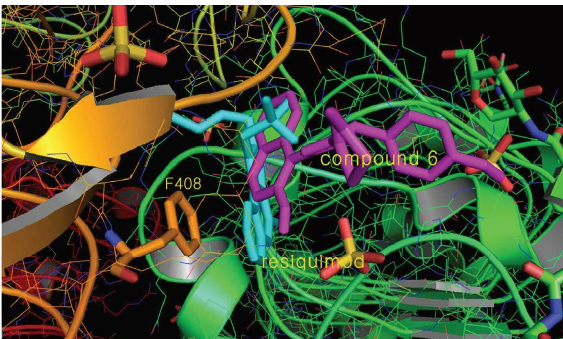
Figure 8: Benzene ring of resiquimod (cyan color) is stacked with the benzene ring of F408. Nevertheless, compound 6 (magenta color) is not stacked because its naphthalene faces diagonally instead of facing side by side with